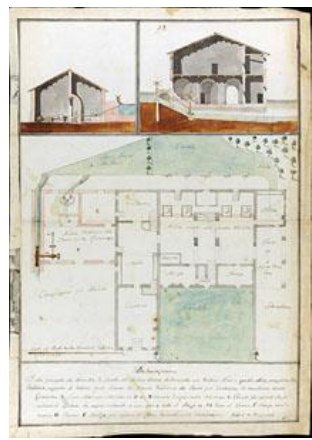
Figure 6. Plant of the Palazzo mill (which no longer exists), Guidi Mauro, 1792. The original document today is kept at the Biblioteca Malatestiana library of Cesena (Bartolini, 2015)